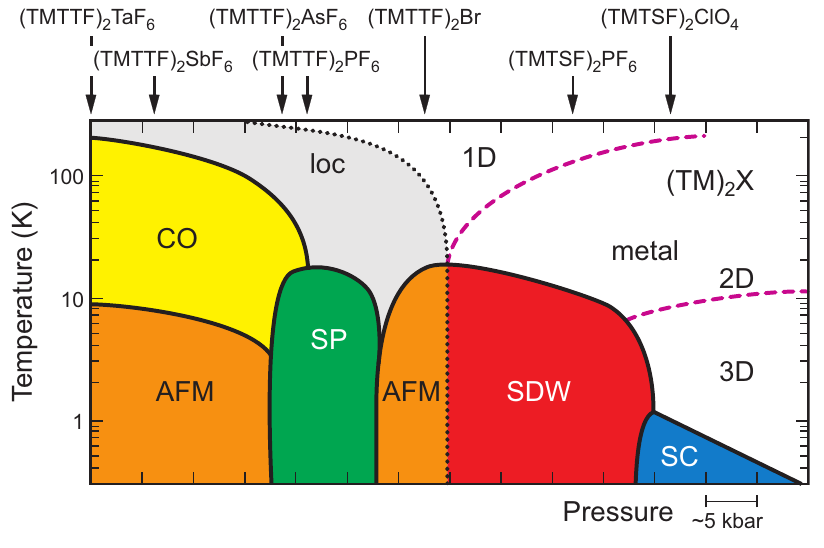
Figure 1. The phase diagram of the quasi one-dimensional TMTTF and TMTSF salts, first suggested by J´erome and coworkers [2] and further supplemented by many groups over the years [5]. For the different compounds with centrosymmetric anions the ambient-pressure position in the phase diagram is indicated. Going from the left to the right, the materials get less one-dimensional due to the increasing interaction in the second and third direction. At low temperatures various broken symmetry ground states develop. Here loc stands for charge localization, CO for charge ordering, SP for spin-Peierls, AFM for antiferromagnet, SDW for spin density wave, and SC for superconductor. While some of the boundaries are clear phase transitions, the ones indicated by dashed lines are better characterized as a crossover. The position in the phase diagram can be tuned by external or chemical